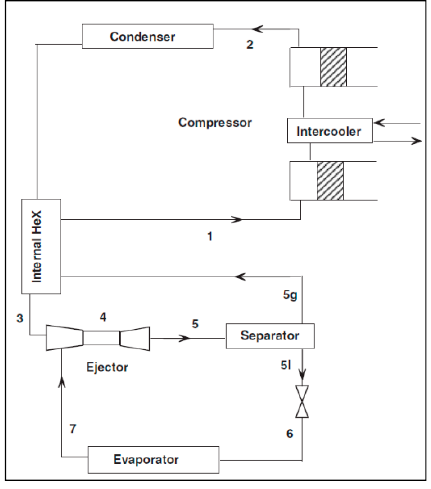
Figure 18. Modified transcritical CO 2 ejector-expansion refrigeration cycle [188].